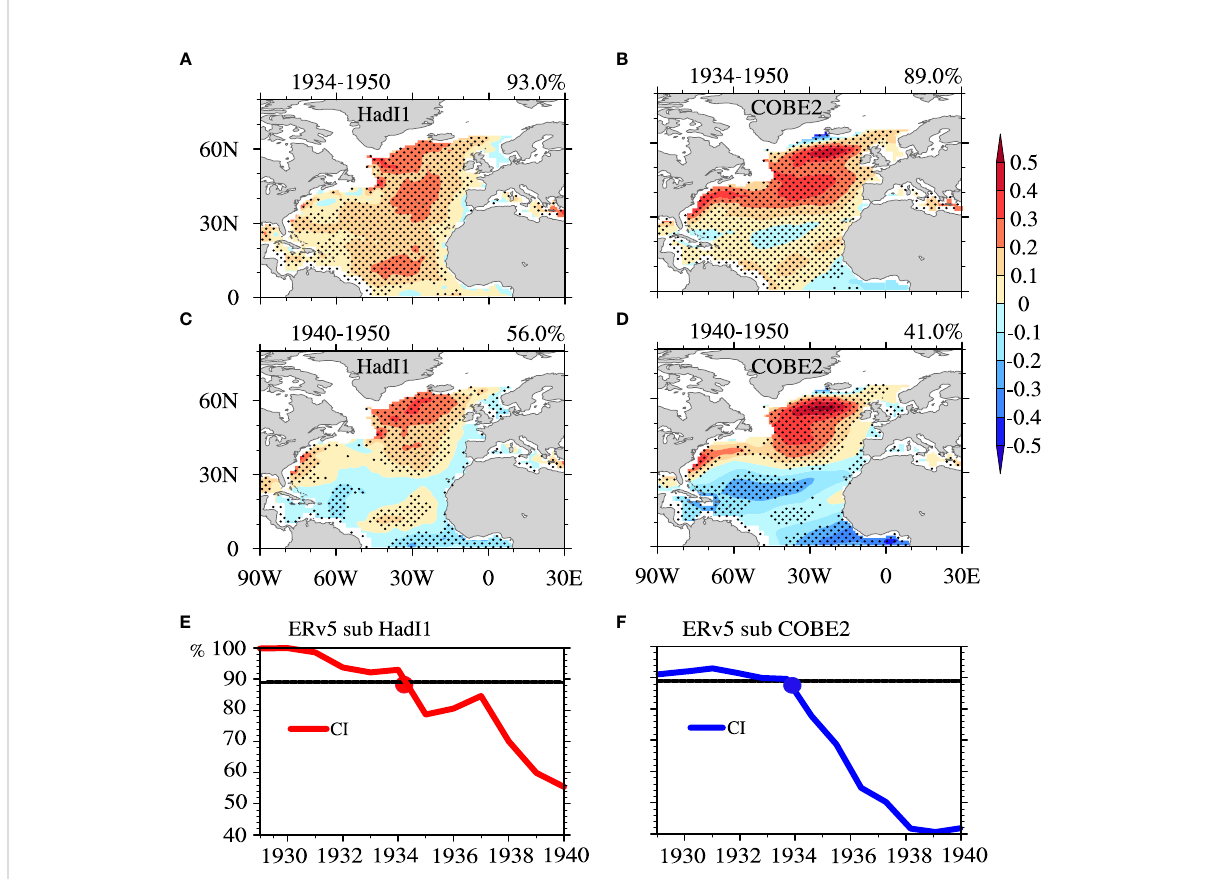
FIGURE 3 AMO patterns obtained from merged datasets based on LFCA. The merged datasets are obtained by replacing the SST data during 19xx – 1950 in ERv5 with those in HadI1 (COBE2), where 19xx ranges from 1930 to 1940 in yearly increments and remains unchanged in other periods. (A, B) AMO patterns when 19xx is 1934 for HadI1 and COBE2, respectively. (C, D) As in (A, B) , respectively, but when 19xx is 1940. (E, F) Change in the AMO CI as 19xx ranges from 1929 to 1940 when replacing HadI1 and COBE2, respectively. The x -axis denotes the period of replacement from 1929 to 1940. The dots in (E, F) are the positions where the CI value reaches the 89% level. Unit: